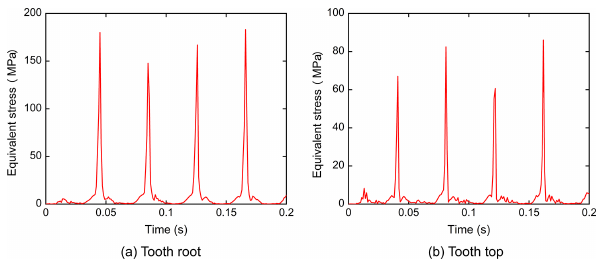
Figure 10. Equivalent stress of dynamic meshing on the output in- ternal bevel gear.